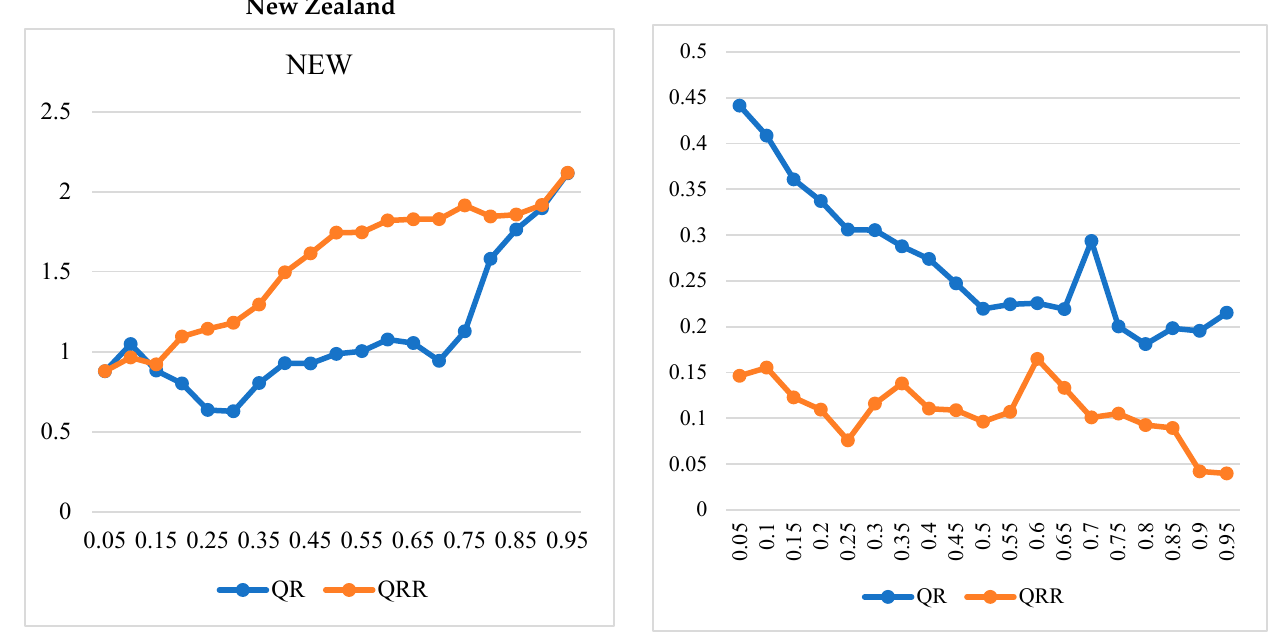
Figure 4. Comparison of Quantile Regression and Quantile on Quantile estimates. Source : Authors’ computation.